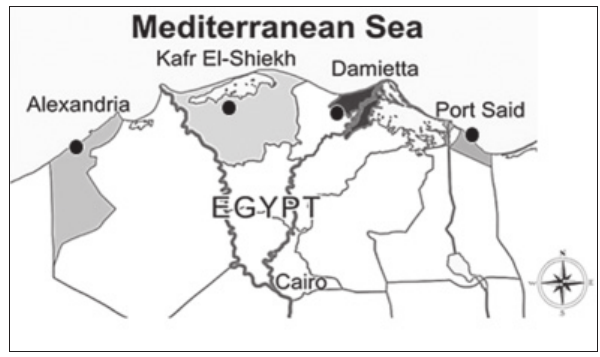
“farm,” Damietta “farm” and Port Said